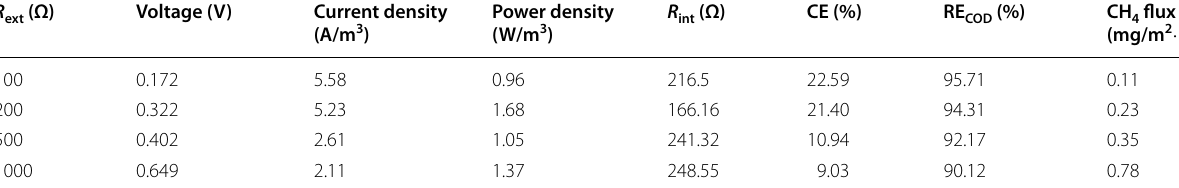
Table 1 Influence of external resistances on the long‑term performance of the CW–MFCs R ext (Ω) Voltage (V) Current density